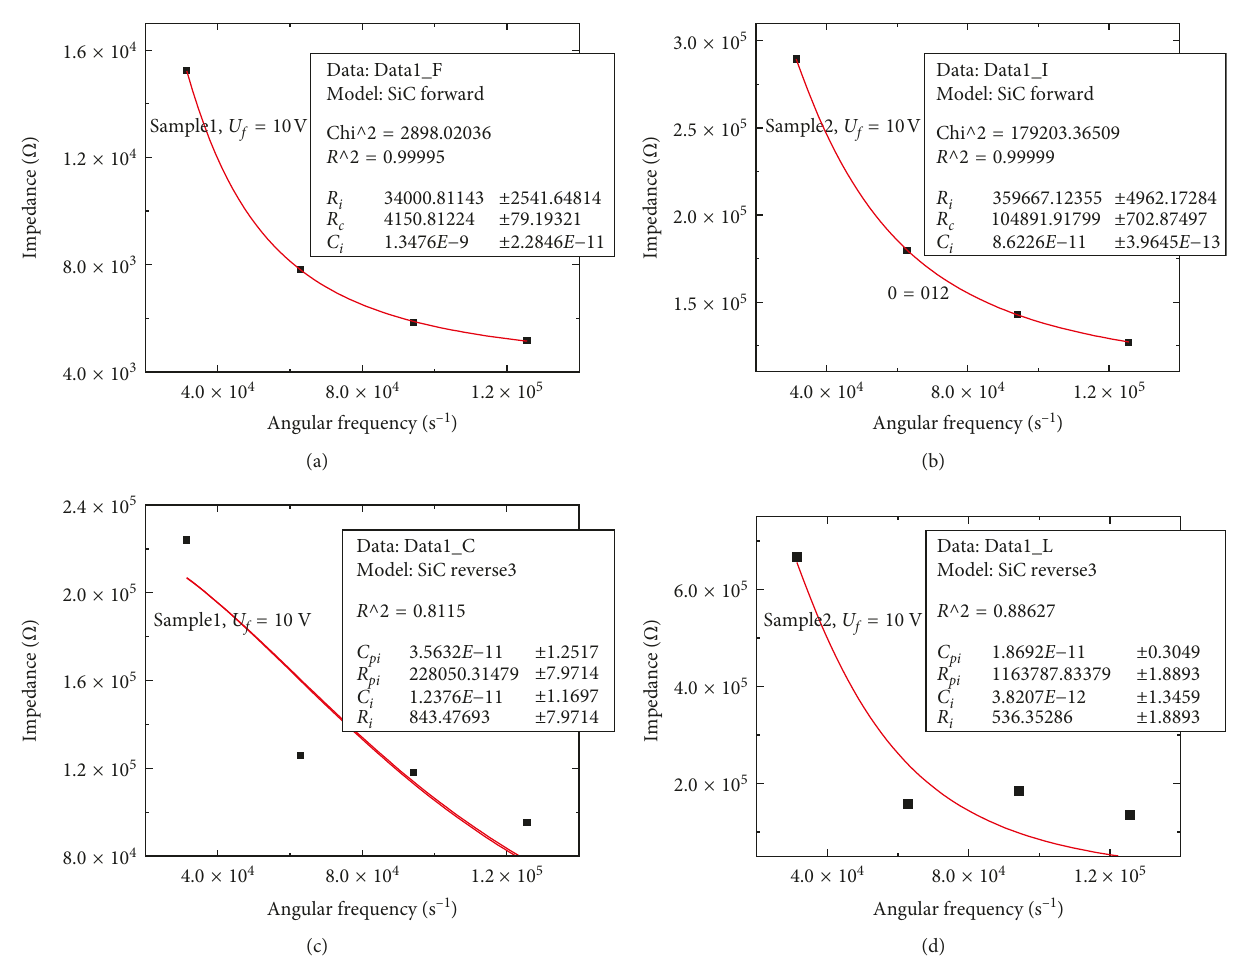
Figure 9: The results of computer fitting to experimental data on impedance at direct (a and b) and at reverse voltage (c and d) for some